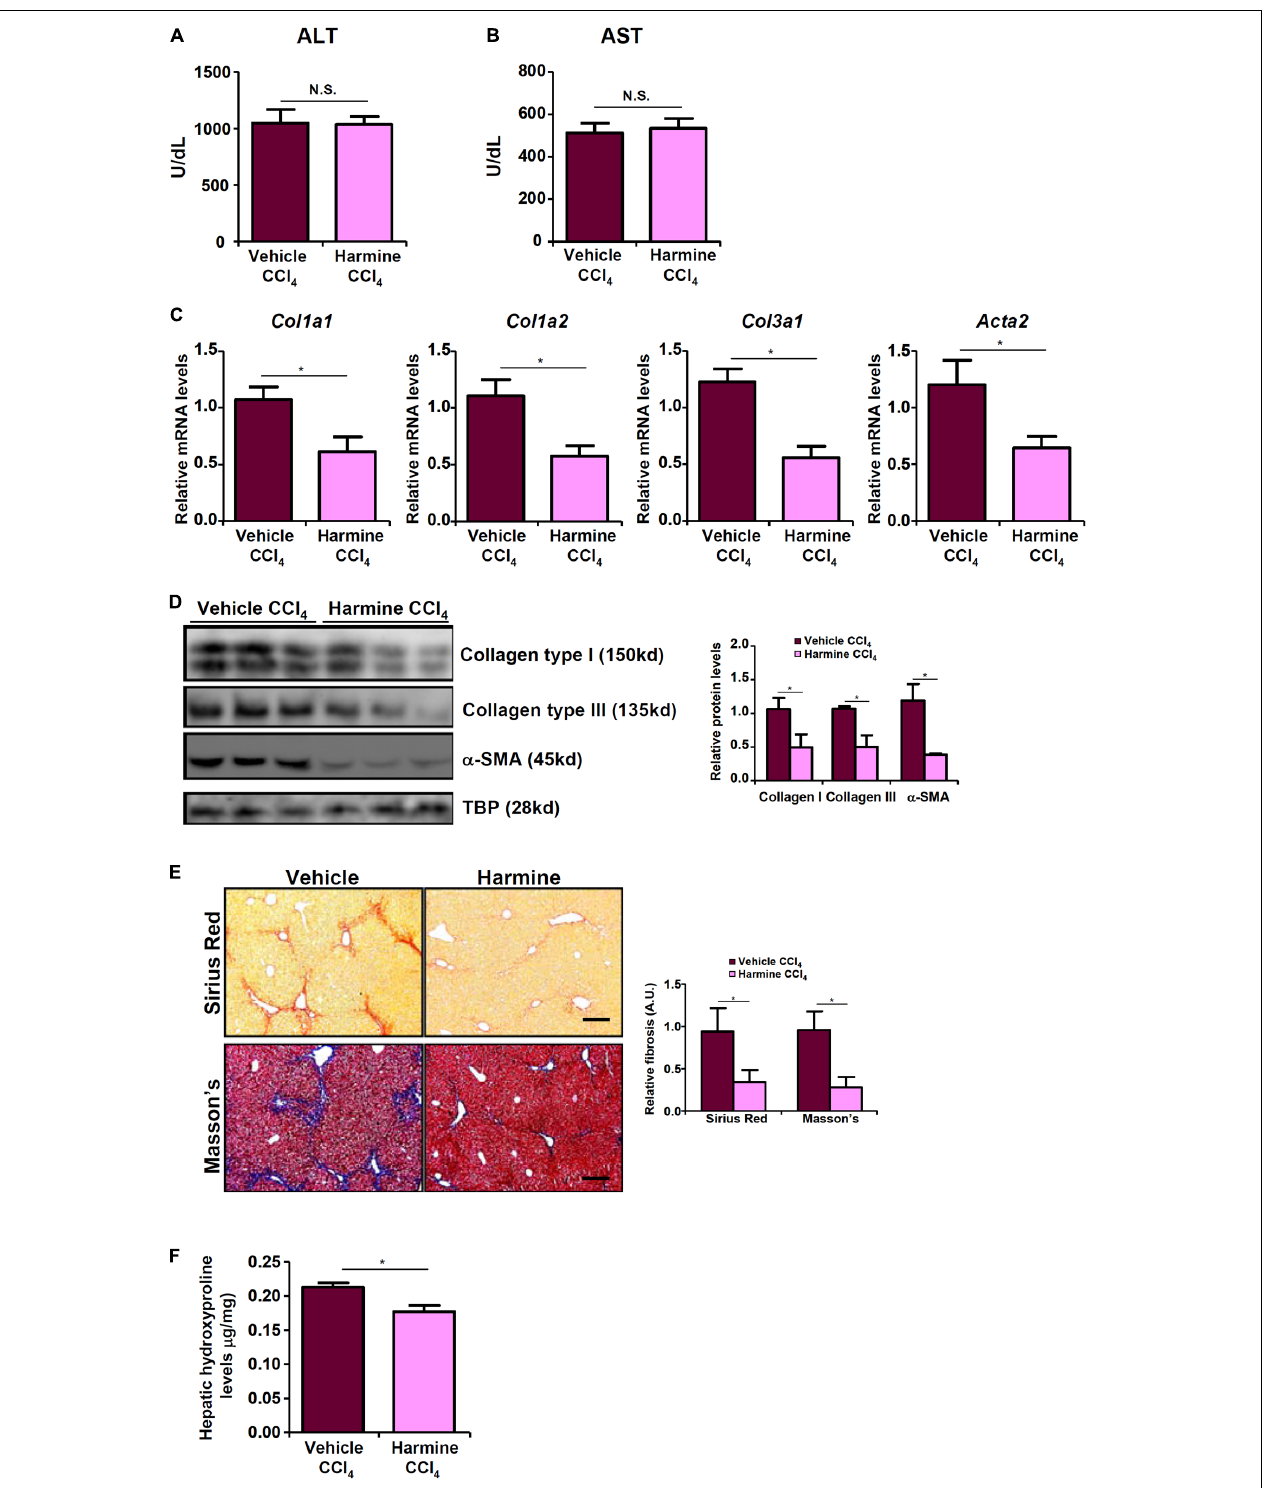
FIGURE 6 | TWIST inhibition attenuates liver fibrosis in mice. Liver fibrosis was induced in by CCl 4 injection. The mice were injected with the TWIST inhibitor harmine every other day. (A) Plasma ALT levels. (B) Plasma AST levels. (C,D) Expression levels of pro-fibrogenic genes were examined by qPCR and Western. (E) Paraffin sections were stained with picrosirius red and Masson’s trichrome. (F) Hepatic hydroxylproline levels. N = 8 mice for each group. Error bars represent SD (* p < 0.05, two-way ANOVA with post-hoc Scheffe test).